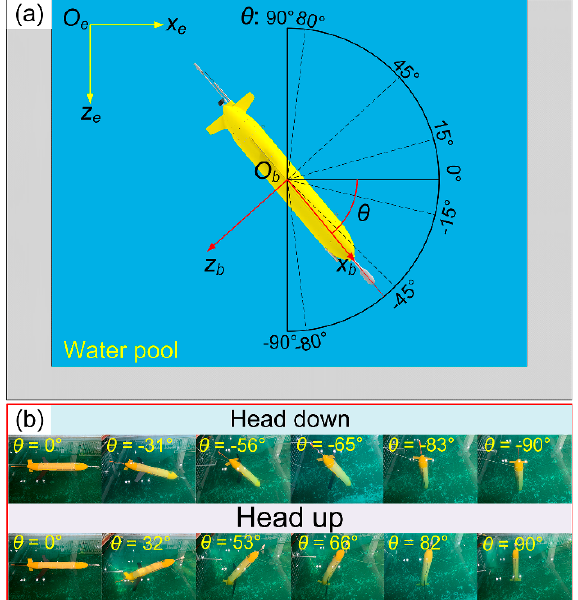
Figure 18. Water pool experiment: ( a ) schematic diagram; ( b )